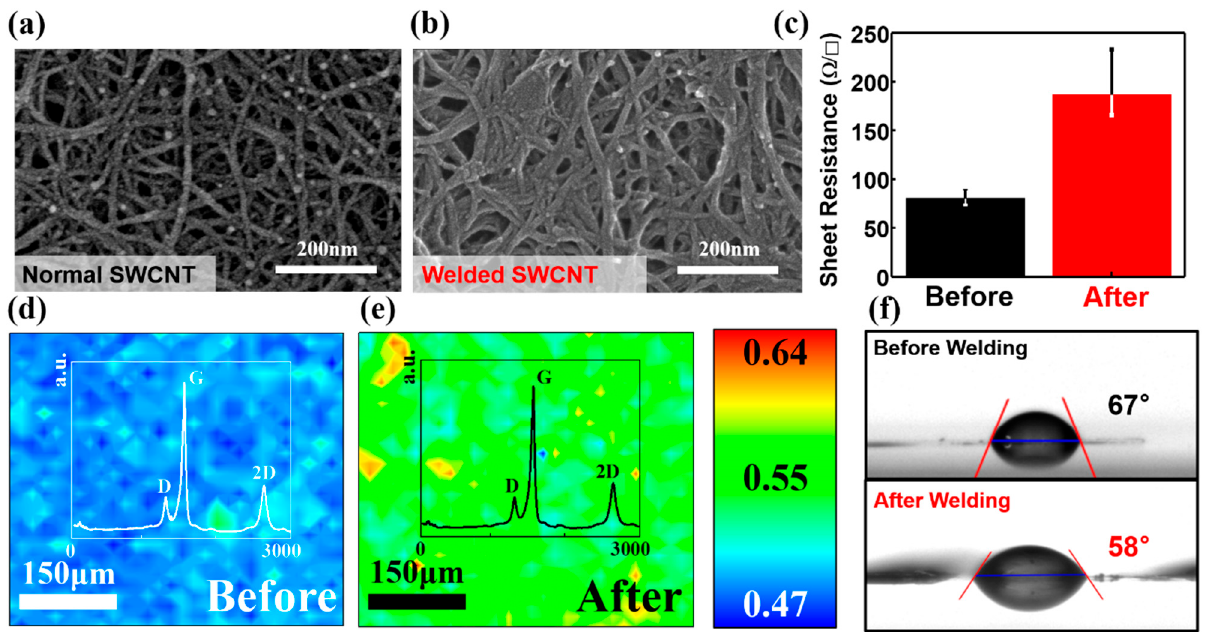
Figure 4. Microstructure of SWCNT 3D pattern. SEM image of SWCNT 3D pattern ( a ) before welding and ( b ) after welding. ( c ) Sheet resistance of 3D pattern before welding and after welding. Raman spectroscopy of 3D pattern ( d ) before welding and ( e ) after welding. ( f ) Contact angle measurement of 3D pattern before welding and after welding.